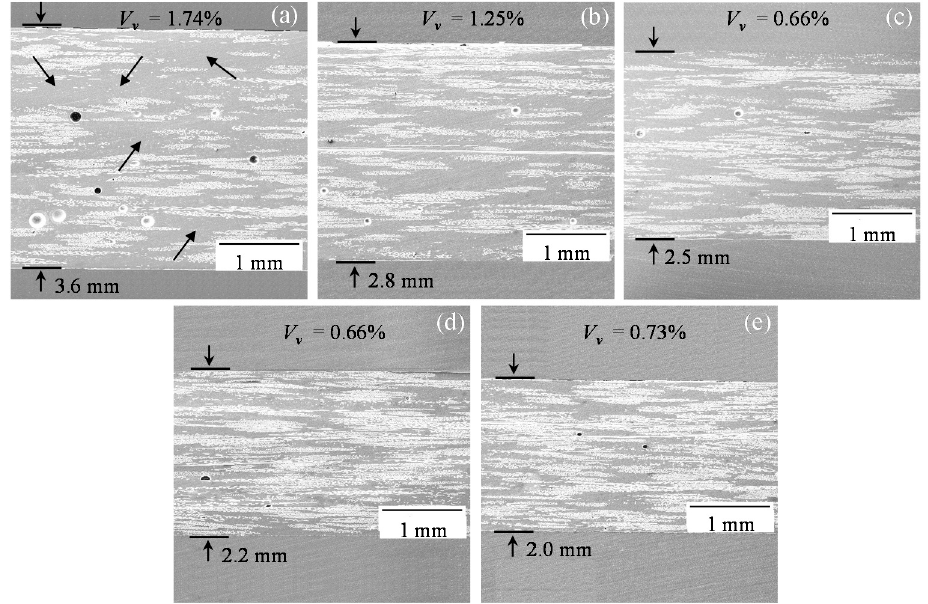
Figure 6. Scanning electron microscopy (SEM) images of random mat laminates (at 20× magnification) made by WLVB process and sliding lifting magnet over the saturated lay-up with ( a ) 0 pass (arrows show the resin-rich inter-tow regions); ( b ) 1 pass; ( c ) 6 passes; ( d ) 12 passes; and ( e ) 18 passes.